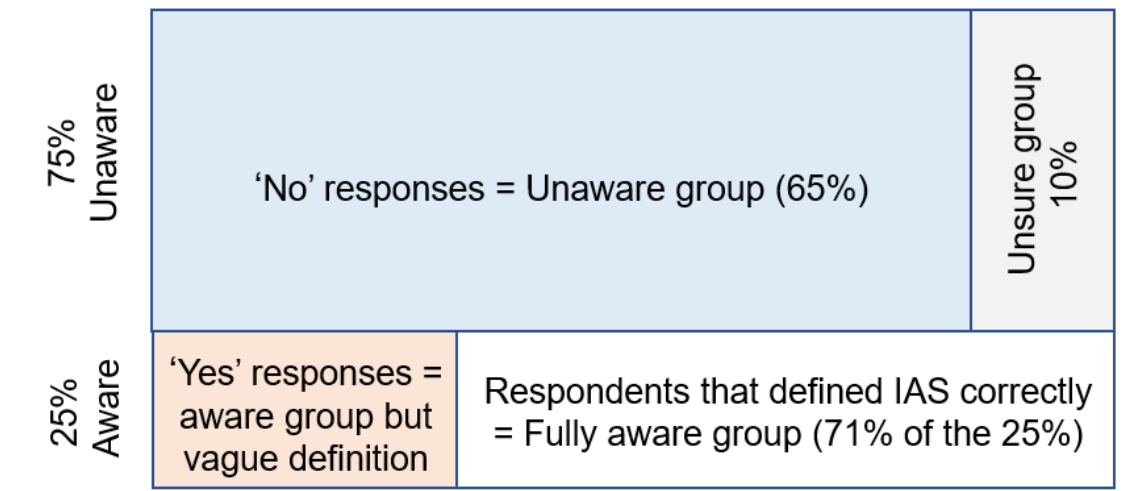
Figure 2. A summary of how the 262 respondents were grouped according to their level of knowledge of invasive alien species. Table 1. Candidate models explaining demographic covariates and species density (continuous independent variable). The models are ordered by their relative AIC, and the best model is highlighted in bold. W i (Akaike weight) is the relative support a model had from the data compared to the other models in the set. Significance levels (P) for models with cate- gorical variables (*) are reported in Supplementary Information S6 (NS: not significant).